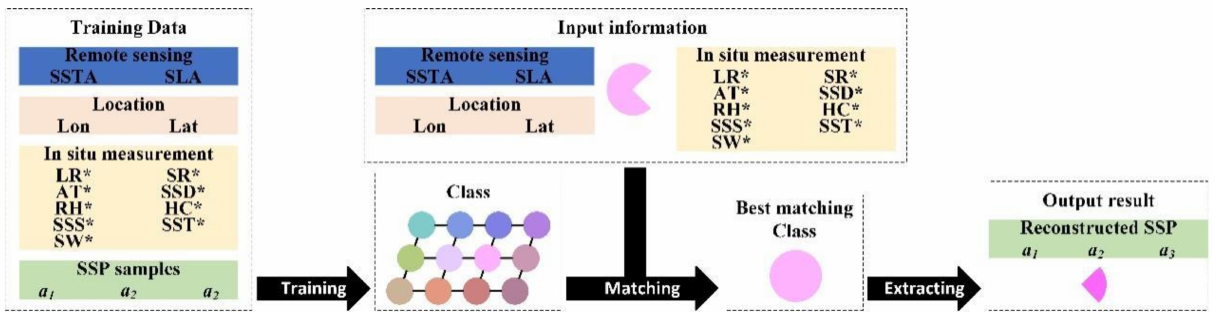
Figure 1. The flow of SOM-based estimation of the